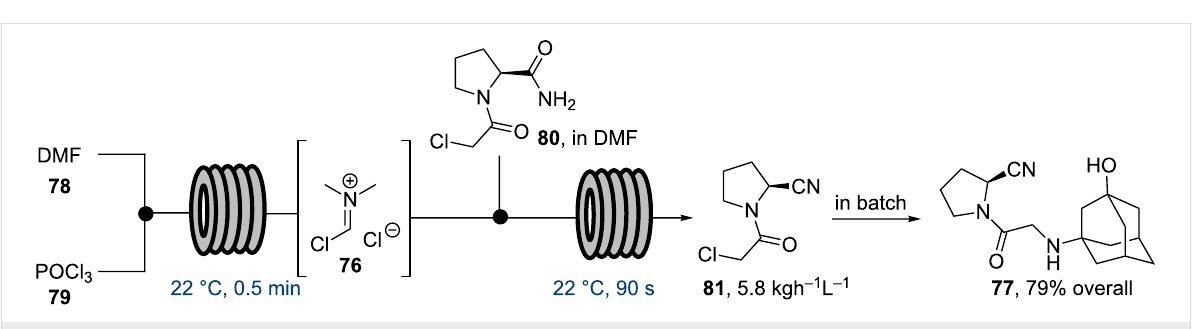
Scheme 13: Semi-flow synthesis of vildagliptine ( 77